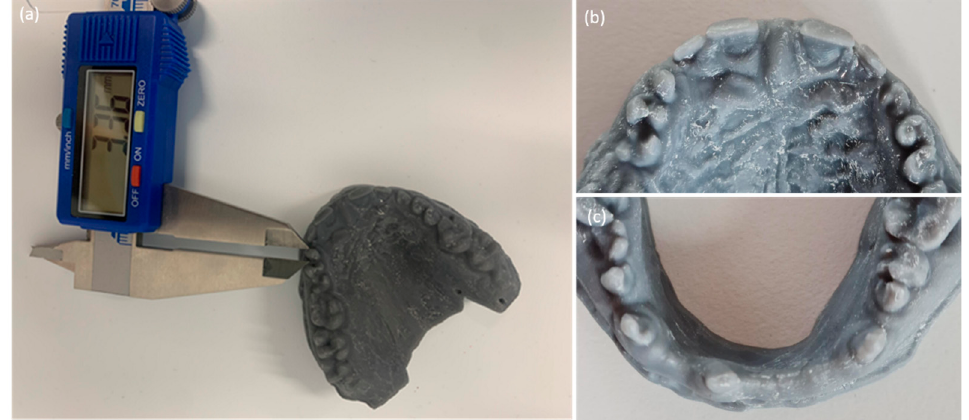
Figure 2. Resin printed study models illustrating microdontia and the abnormal morphology of the clinical crowns: ( a ) maxillary model; ( b ) model of anterior maxillary segment; ( c ) model of anterior mandibular segment.